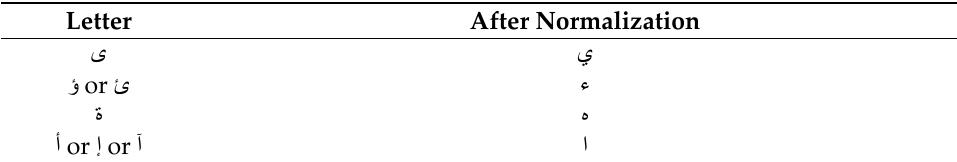
Table 4. Example of implementing the pre-processing steps on a tweet .